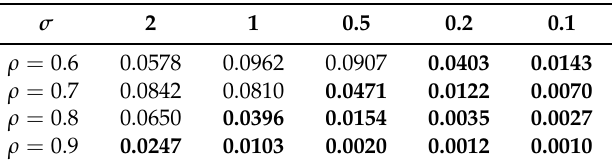
Table 1. Values of Kolmogorov distance ( ∆ ) of approximation distribution P A given by (53) and its exact one (by simulation) for various values of σ (retrial rate) and ρ (traffic intensity). The cases with ∆ ≤ 0.05 are in boldface.